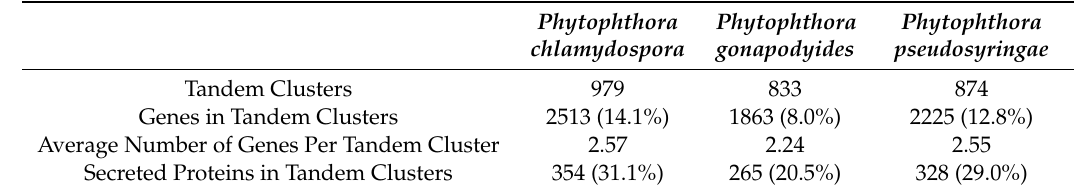
Table 5. Tandem gene